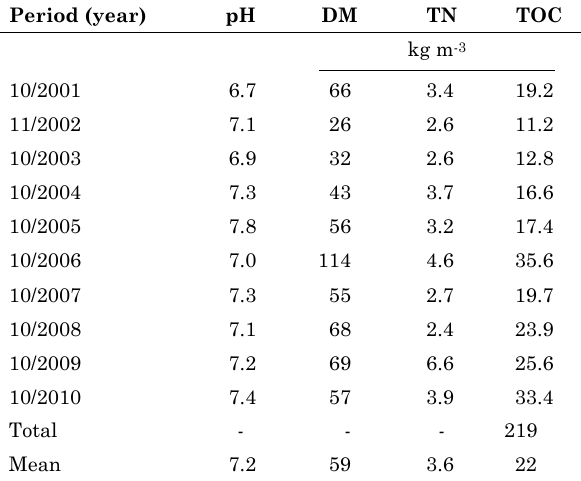
Table 3. Chemical properties (dry matter - Dm; total nitrogen - Tn; and total organic carbon - TOC) of the pig slurry applied annually in the field experiment in the period from 2001 to 2011 in a latossolo Vermelho distroférrico (Typic Hapludox) Period